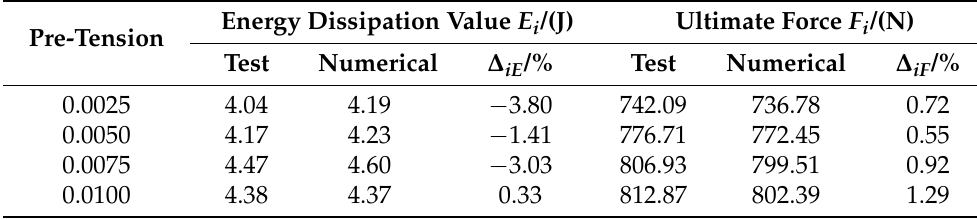
Table 5. Comparison of the results under different